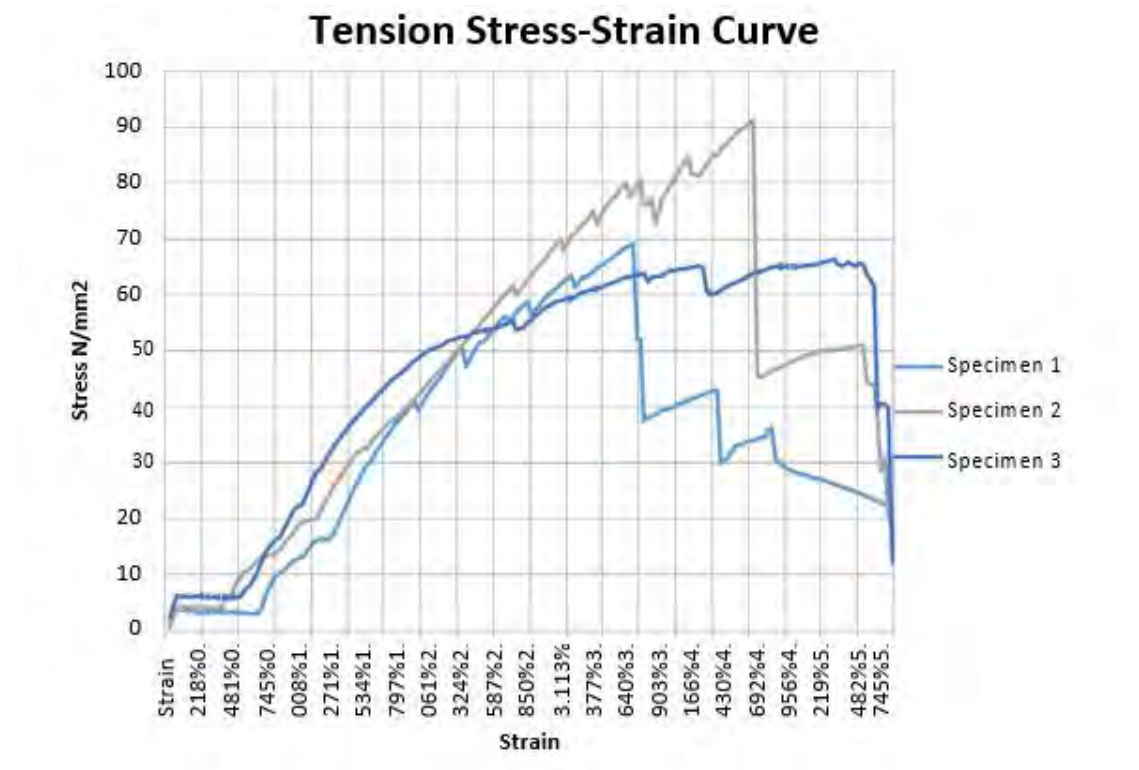
Figure 21. Tensile Stress-Strain Curves of the 3 specimens